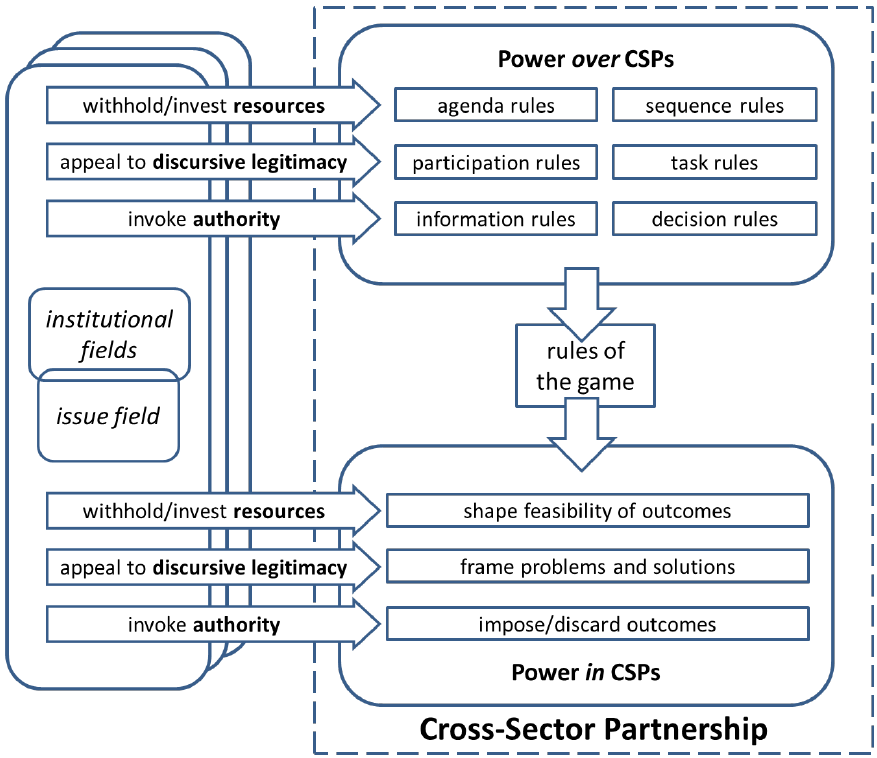
Figure 2. Mobilizing sources of power in strategies for exercising power in and over CSPs.